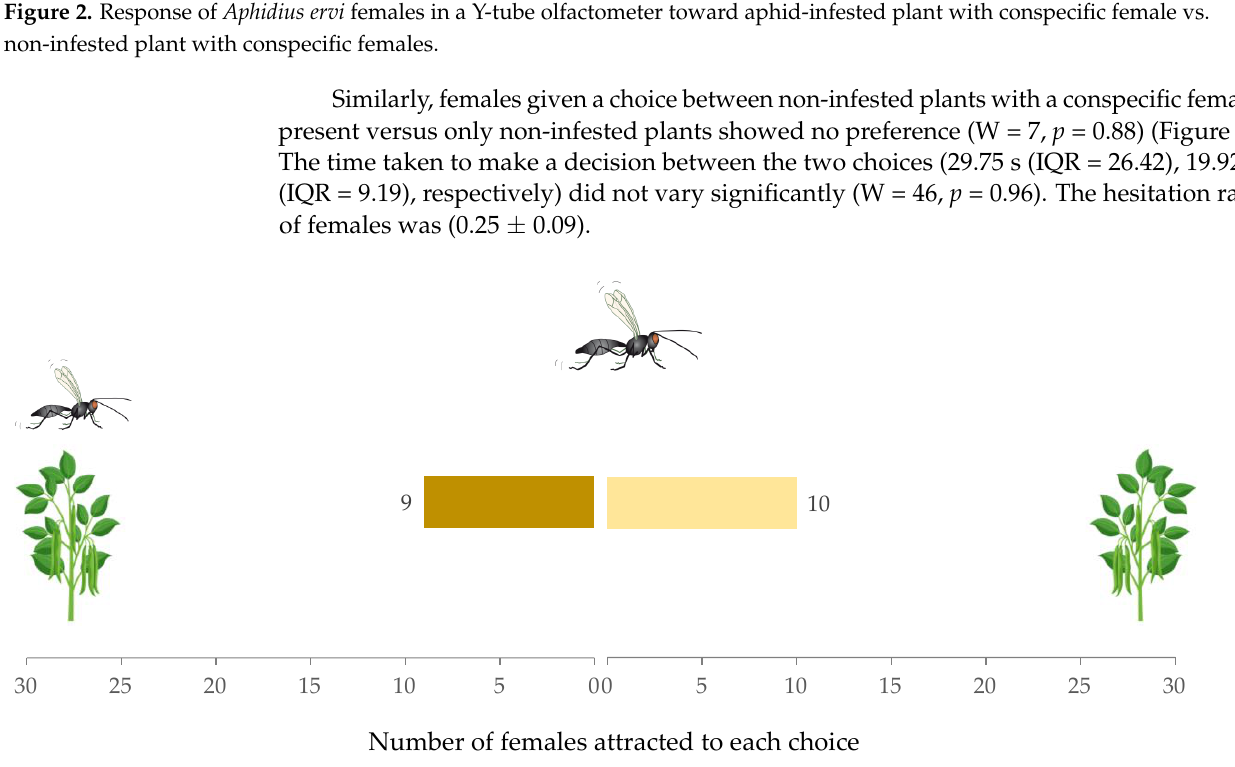
Figure 3. Response of Aphidius ervi females in a Y-tube olfactometer toward non-infested plant with conspecific female vs. non-infested plant.